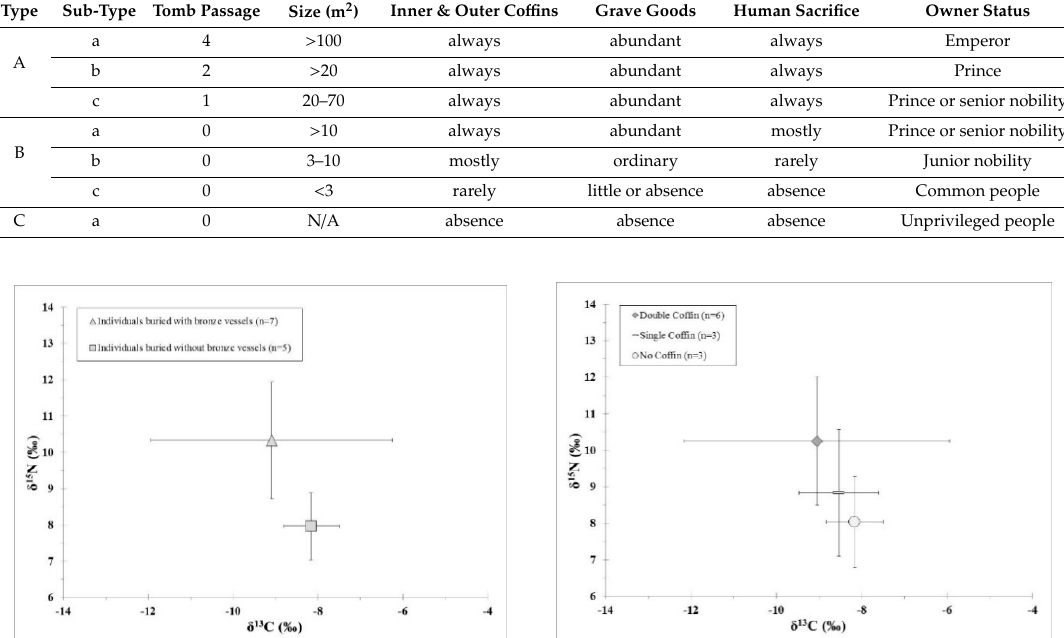
Figure 5. ( a ) δ 13 C and δ 15 N results showing the di ff erences between individuals buried with and without bronze vessels at the Xiaohucun site, Henan Province, China. The δ 15 N results are statistically significant (one-way ANOVA; p = 0.015); ( b ) δ 13 C and δ 15 N results for individuals buried in a double, single, or without a co ffi n at the Xiaohucun site, Henan Province, China. The δ 15 N results were not found to be statistically significant using one-way ANOVA tests (double vs. single, p = 0.288; double vs. none, p =